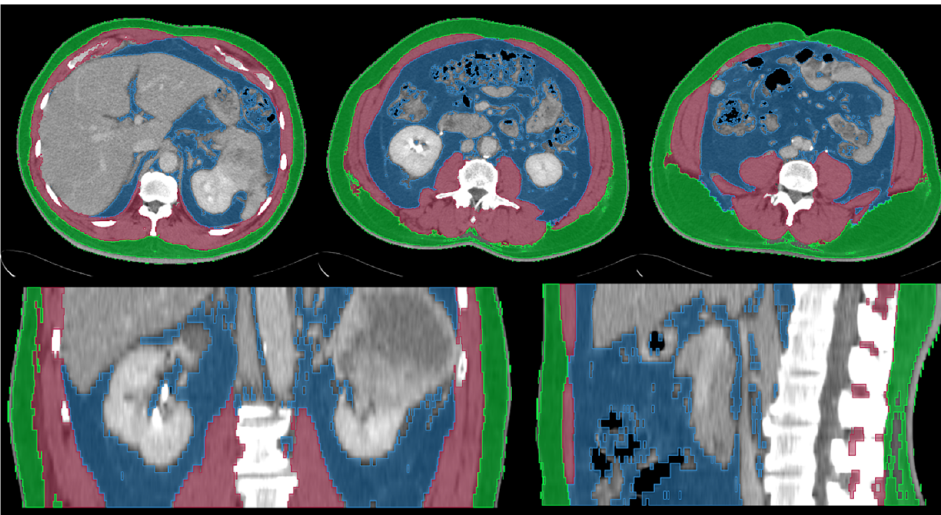
Figure 1. Example of abdominal computed tomography body composition analysis ( upper left : axial plane at the level of costophrenic angle, upper middle : axial plane at the level of L3, upper right : axial plane at the level of iliac crest, lower left : coronal plane, lower right : sagittal plane). Skeletal muscles tissue (red area), subcutaneous adipose tissue (green area), and visceral adipose tissue (blue area) were segmented. Three-dimensional (3D) volumes from the level of costophrenic angle to iliac crest and two-dimensional (2D) cross-section areas at the level of L3 were calculated.